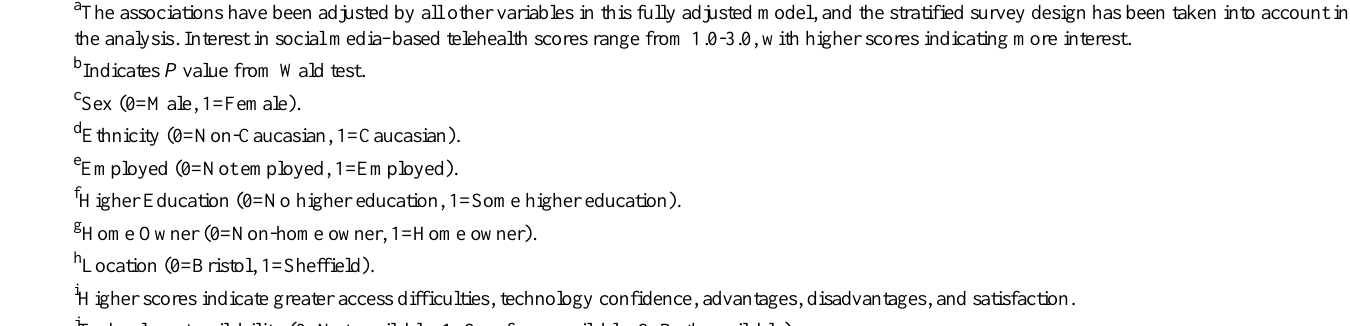
Patient group: depression (n=489)Patient group: CVD risk